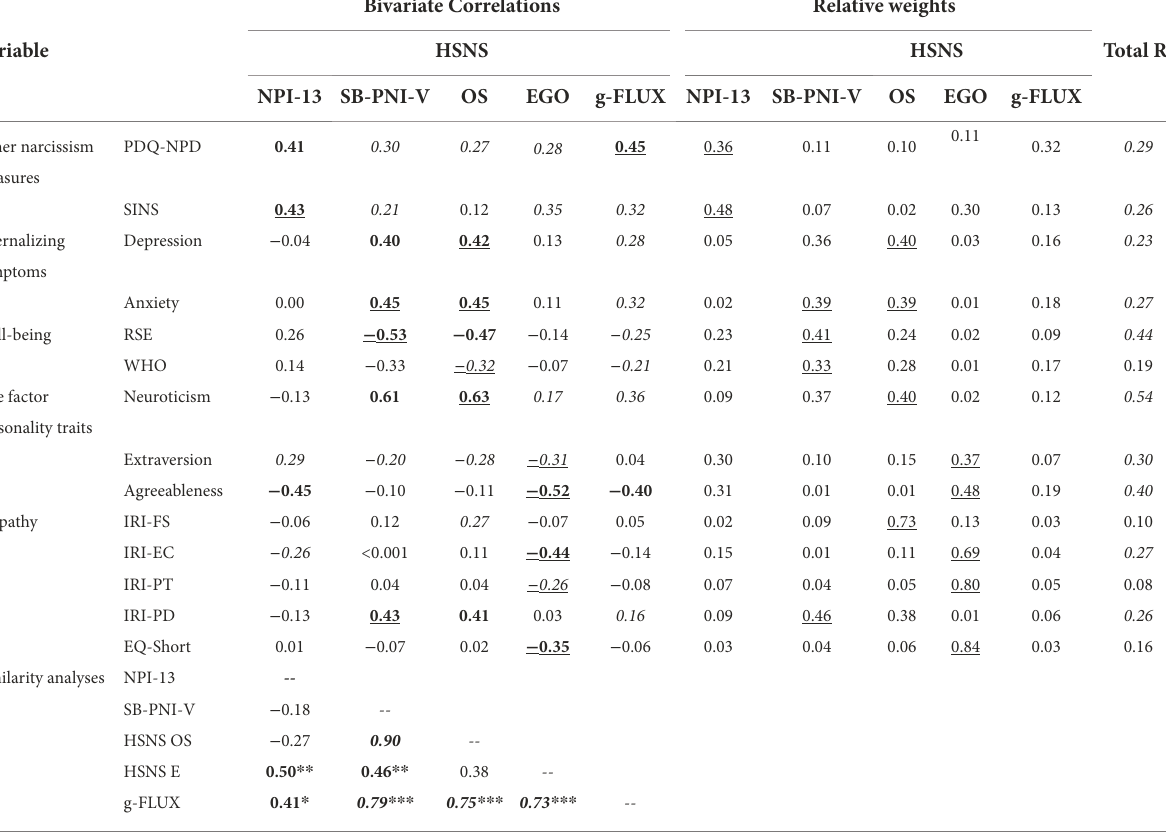
Bivariate Correlations Relative weights